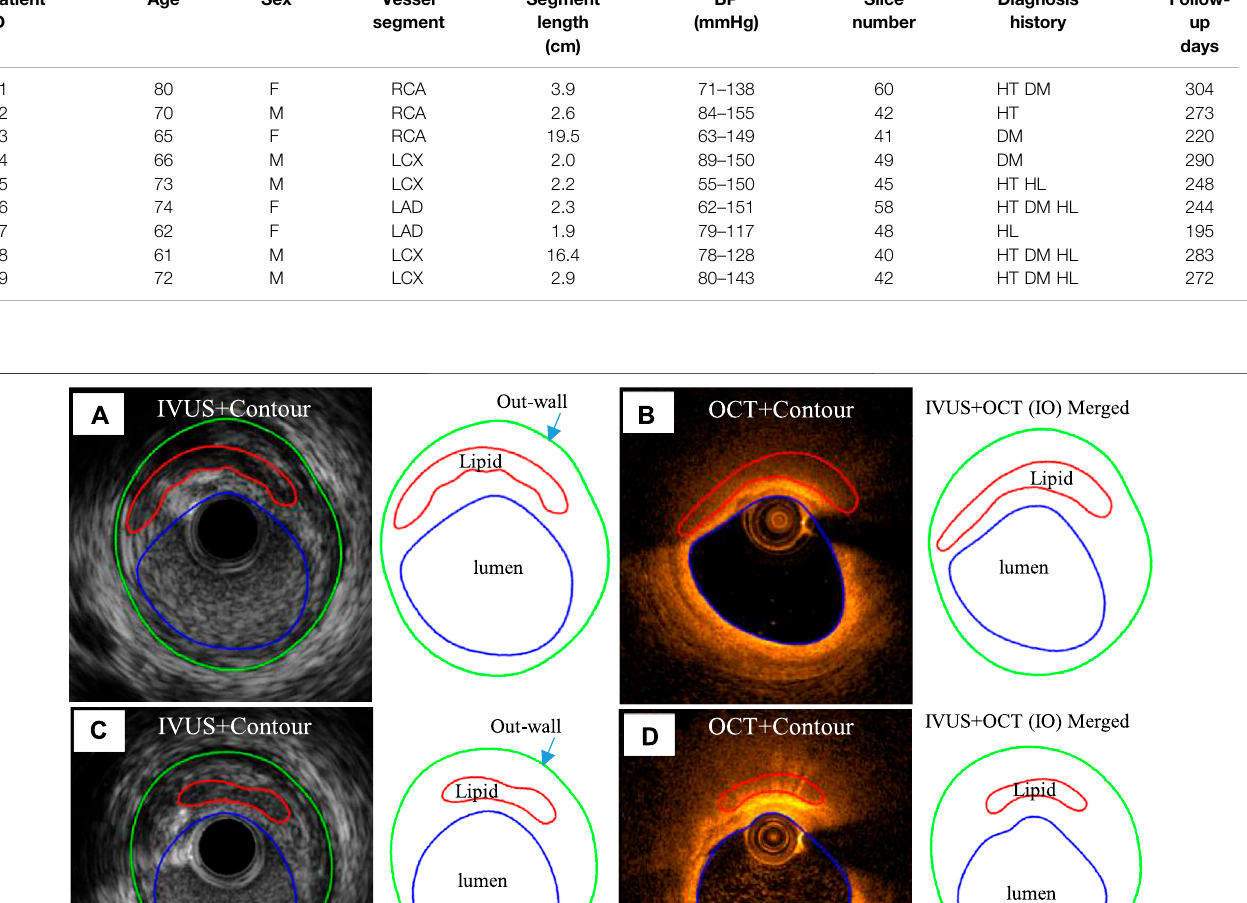
Frontiers in Bioengineering and Biotechnology |